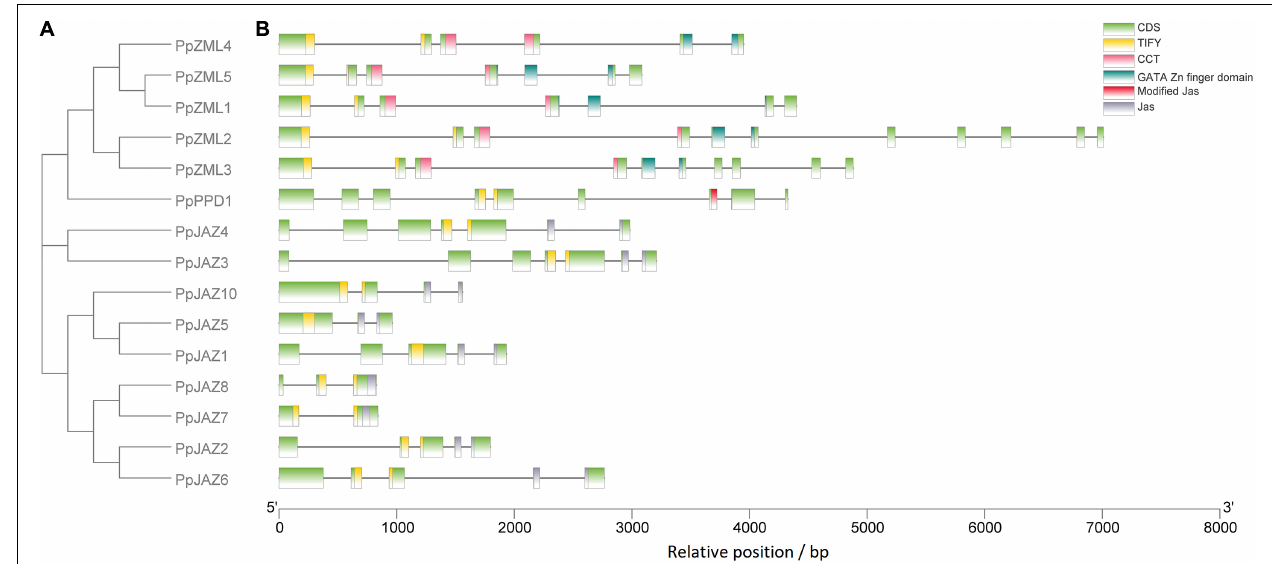
FIGURE 3 | Structural analysis of the peach JAZ, PPD, and ZML members. (A) The topology of the bootstrap consensus tree inferred from deduced amino acid sequences of peach JAZ, PPD, and ZML members with 1000 replicates; (B) Locations of the exons, introns, domains and motifs for each peach member. The x -axis shows the relative position in the peach reference genome. Introns are represented by black lines, whereas exons and domains are represented by colored boxes, as shown in the upper right